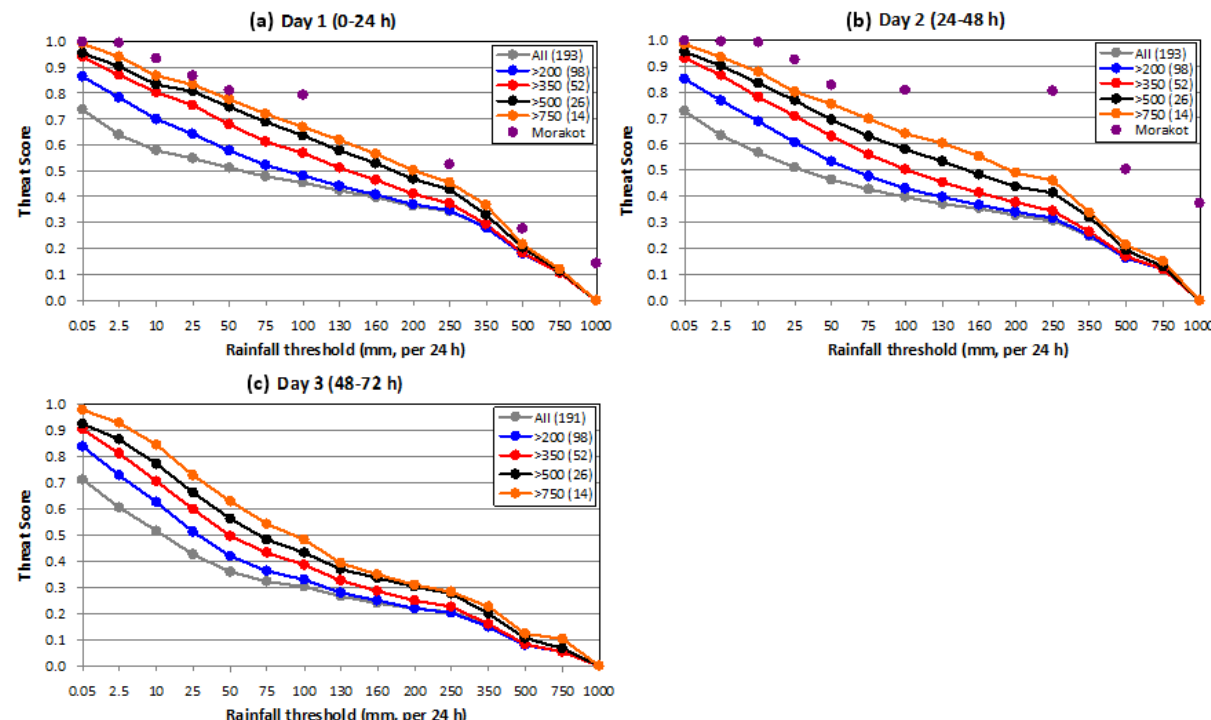
Figure 7. As in Figure 6a–c, but showing the TS computed for ( a ) day 1, ( b ) day 2, and ( c ) day 3 for all segments and the groups with observed peak 24 h rainfall reaching 200, 350, 500, and 750 mm for typhoons in 2010–2015, as well as for Morakot (days 1–2 only). The total numbers of 24 h segments in each group are given in the parentheses, and the scores for all events and Morakot are identical to those in Figure